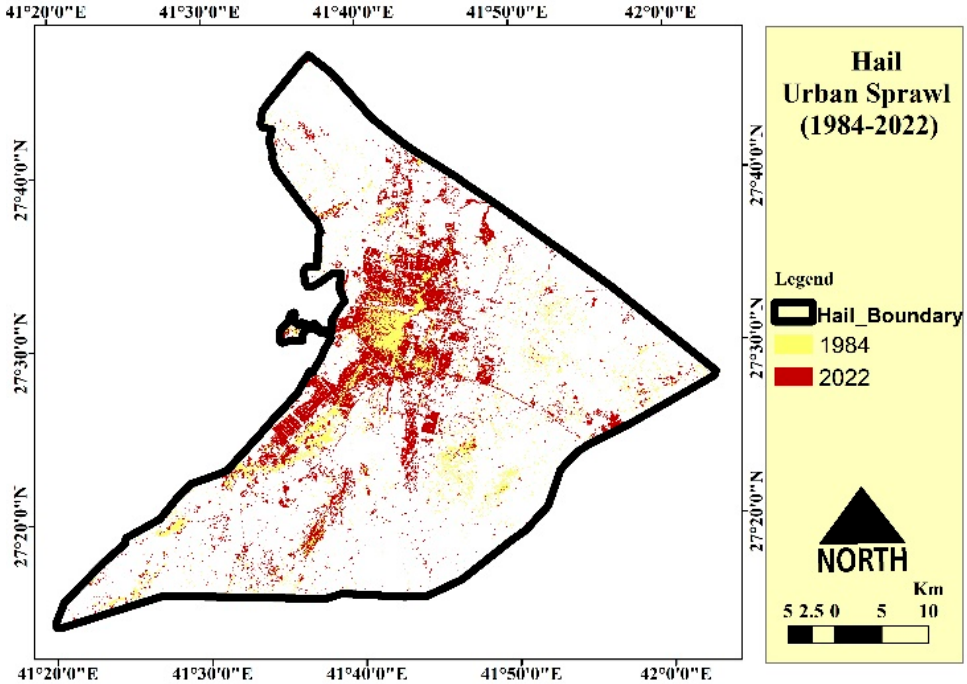
15 of 24 Table 4. Kappa results for land use classification, 2022. Class Value